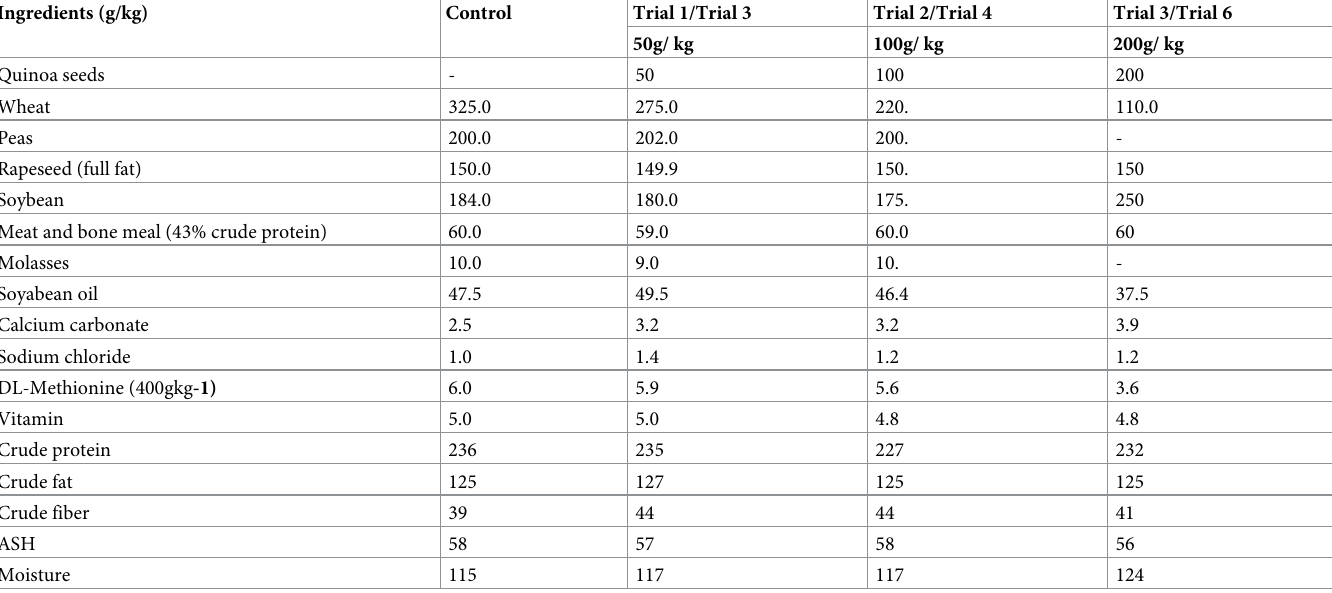
Table 3. Different compositions of quinoa supplemented diets used to feed broiler